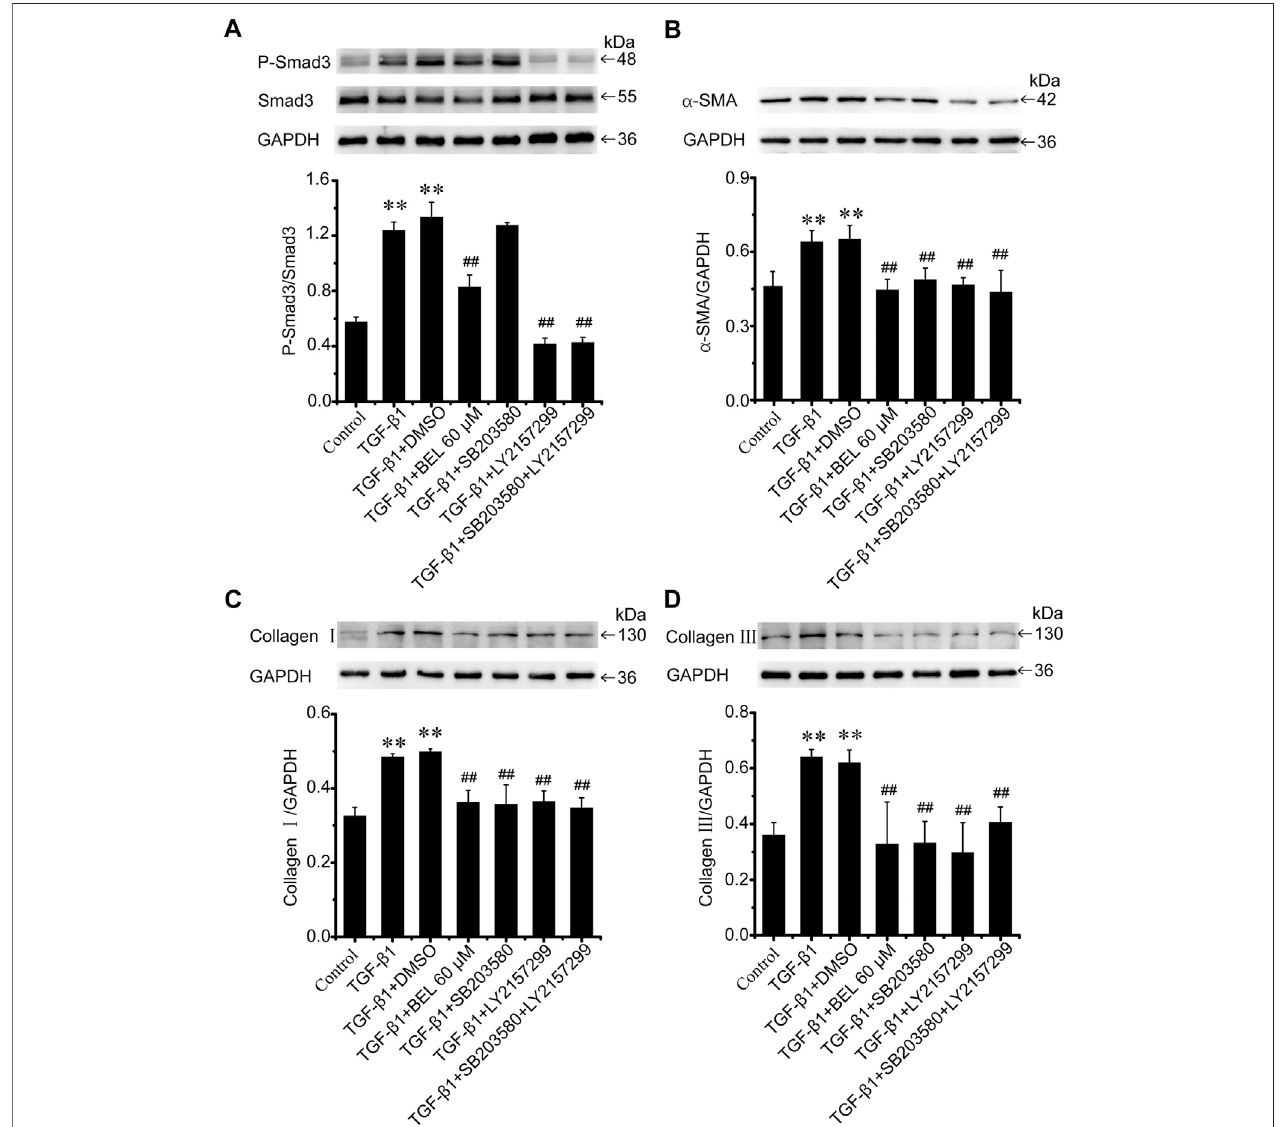
FIGURE 10 | BEL inhibits Smad3 phosphorylation independent of p38 in CFs (A) The expression of Smad3 and the level of P-Smad3 by western blotting. Bar graphs show fold changes of P-mad3/Smad3 ( n (cid:2) 3) (B – D) Expression of α -SMA, collagen Ⅰ , and collagen Ⅲ in CFs. Bar graphs show fold changes for the collagen Ⅰ , collagen Ⅲ , and α -SMA expression as analyzed by western blotting. GAPDH was used as a loading control ( n (cid:2) 3). Data were shown as mean ± SEM. ** p < 0.01 vs. control, ## p < 0.01 vs. TGF- β 1.